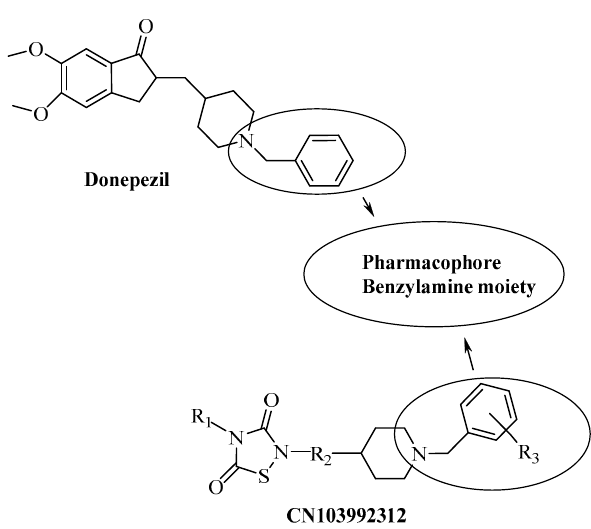
Figure 2. Some AchE inhibitors, including a benzylamine moiety.